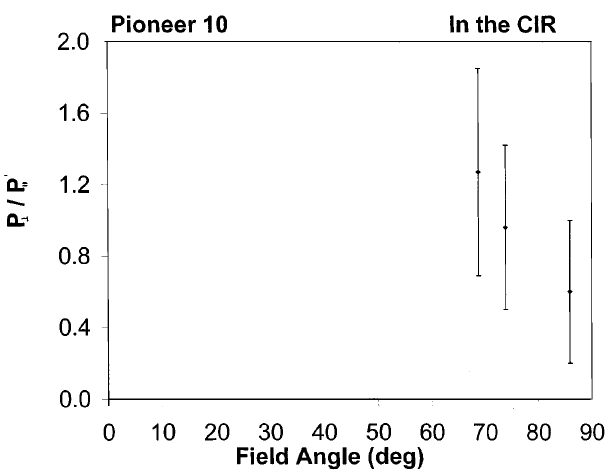
Fig. 4. Ratio P ? = P 0 as a function of the angle of the mean magnetic k field within